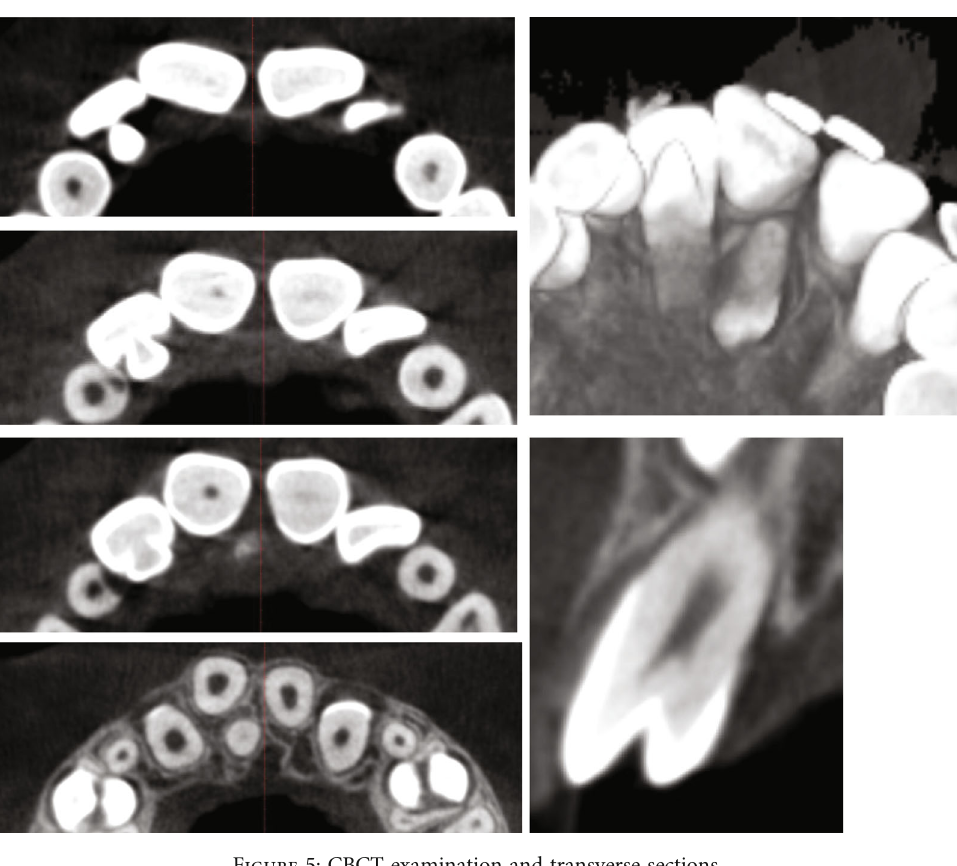
Figure 5: CBCT examination and transverse sections.